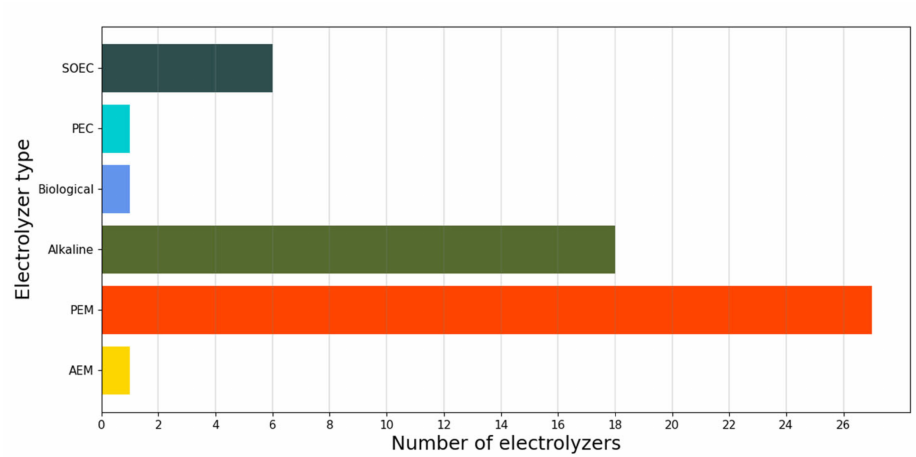
Figure 5. Number of power-to-gas projects per electrolyzer type (PEM = proton exchange membrane, SOEC = solid oxide electrolysis cell, PEC = photoelectrochemical water splitting, AEM = anionic exchange membrane).